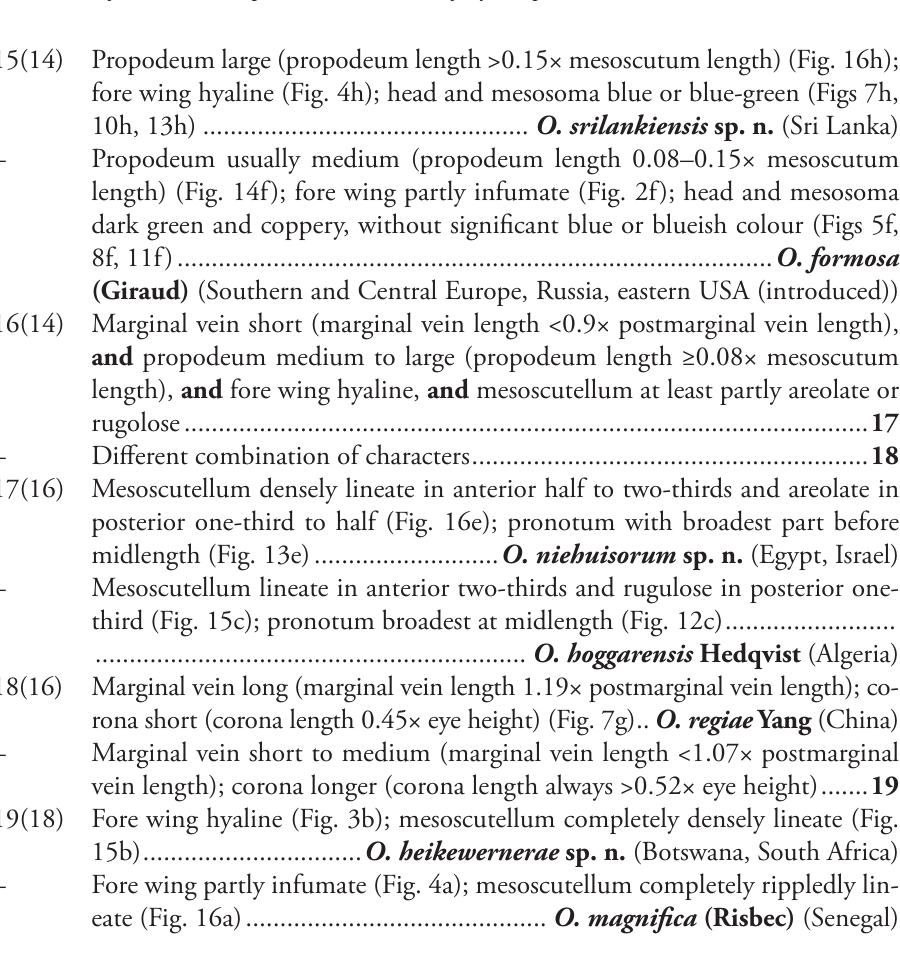
Propodeum large (propodeum length >0.15× mesoscutum length) (Fig. 16h); fore wing hyaline (Fig. 4h); head and mesosoma blue or blue-green (Figs 7h, 10h, 13h) ................................................ O. srilankiensis sp. n. (Sri Lanka)